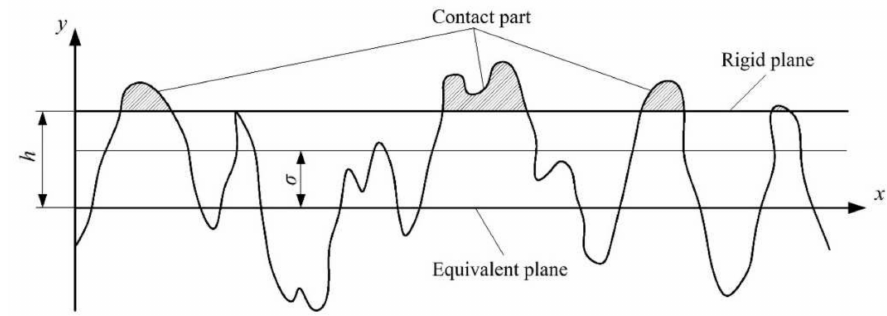
Figure A2. Micro schematic diagram of planes